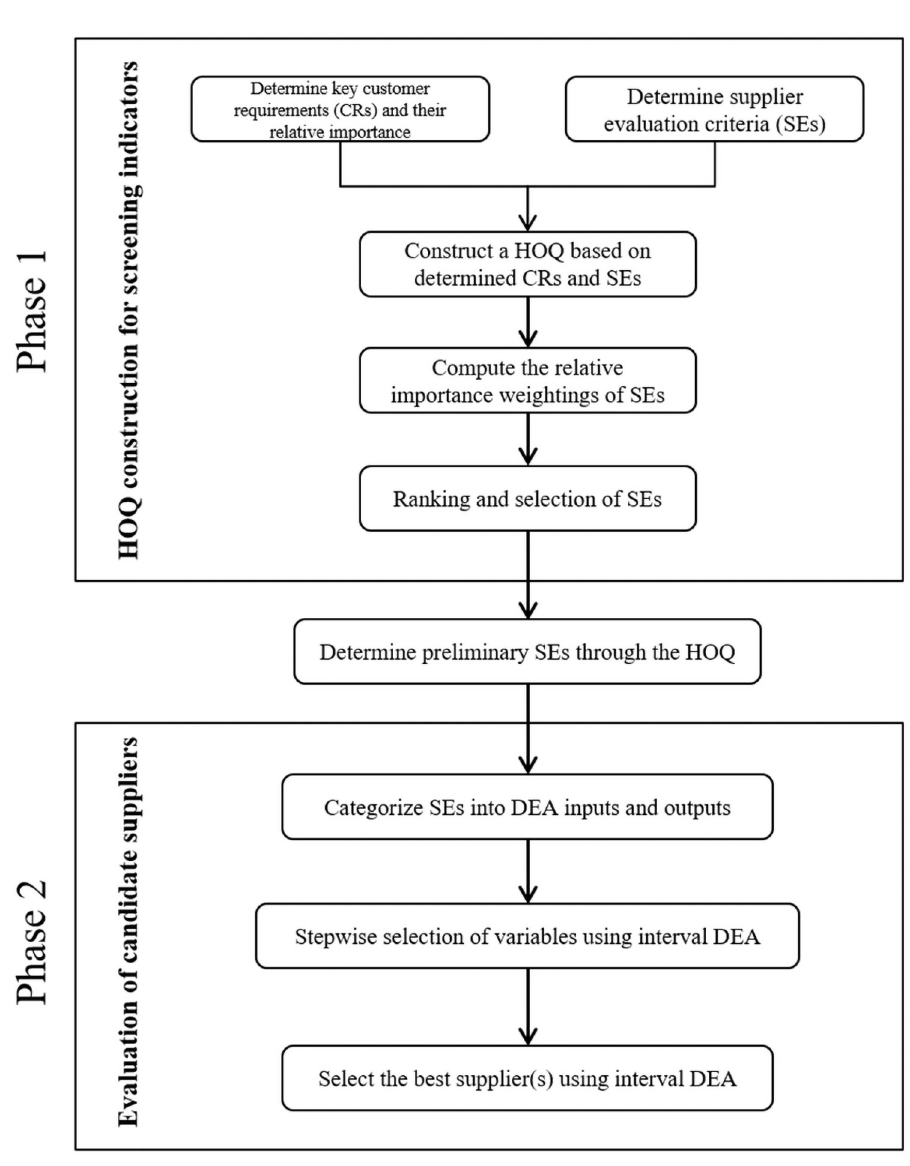
Fig 2. Presentation of the proposed integrated supplier selection